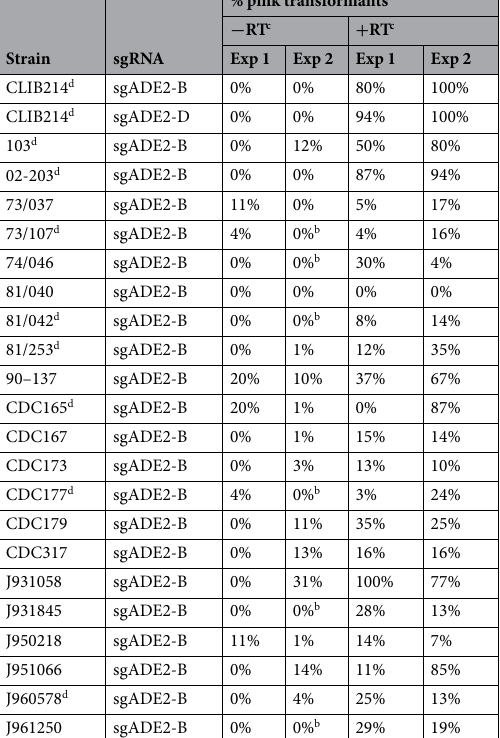
CRISPR system, we replaced the gRNA with a second sequence (sgADE2-D, Supplementary Table S1) also tar- geting ADE2 ( + 451 bp from ATG). Once again, transformation of C . parapsilosis CLIB214 with pRIBO-ADE2-D